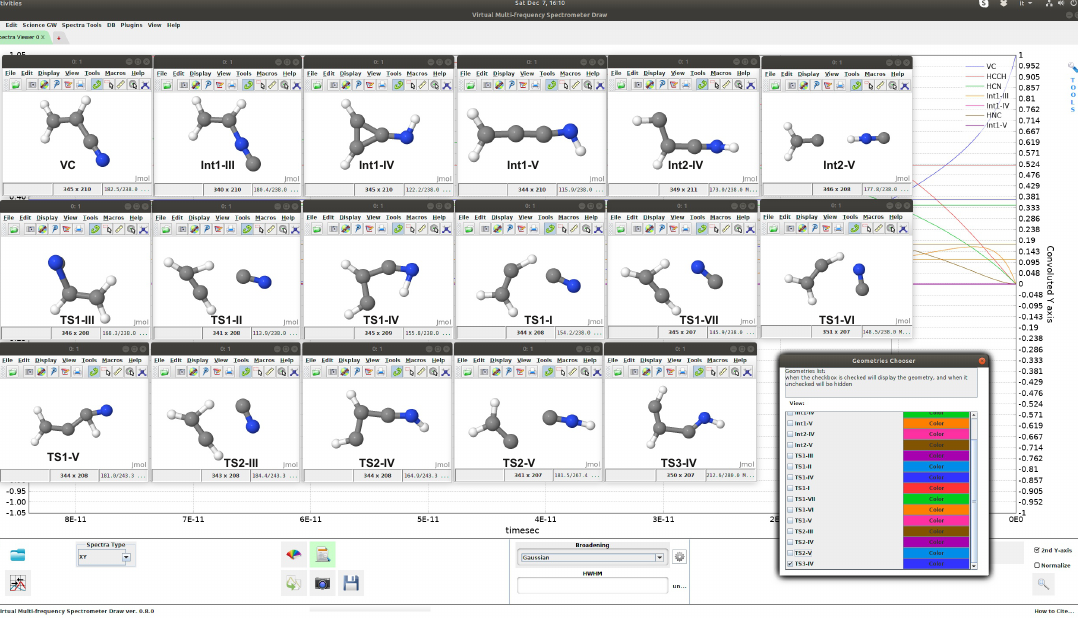
Figure 7. Structures of the reactant molecule (top left corner), intermediates (remaining frames in the top row), and transition states (second and third rows) visualized through the VMS